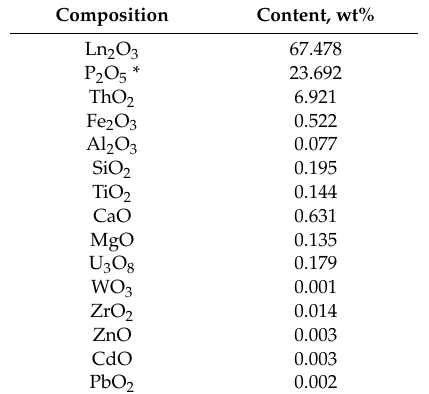
Table 1. The average composition of monazite concentrate located at the UralMonatsit State Institution near the town of Krasnoufimsk, Sverdlovsk Region. * = calculated